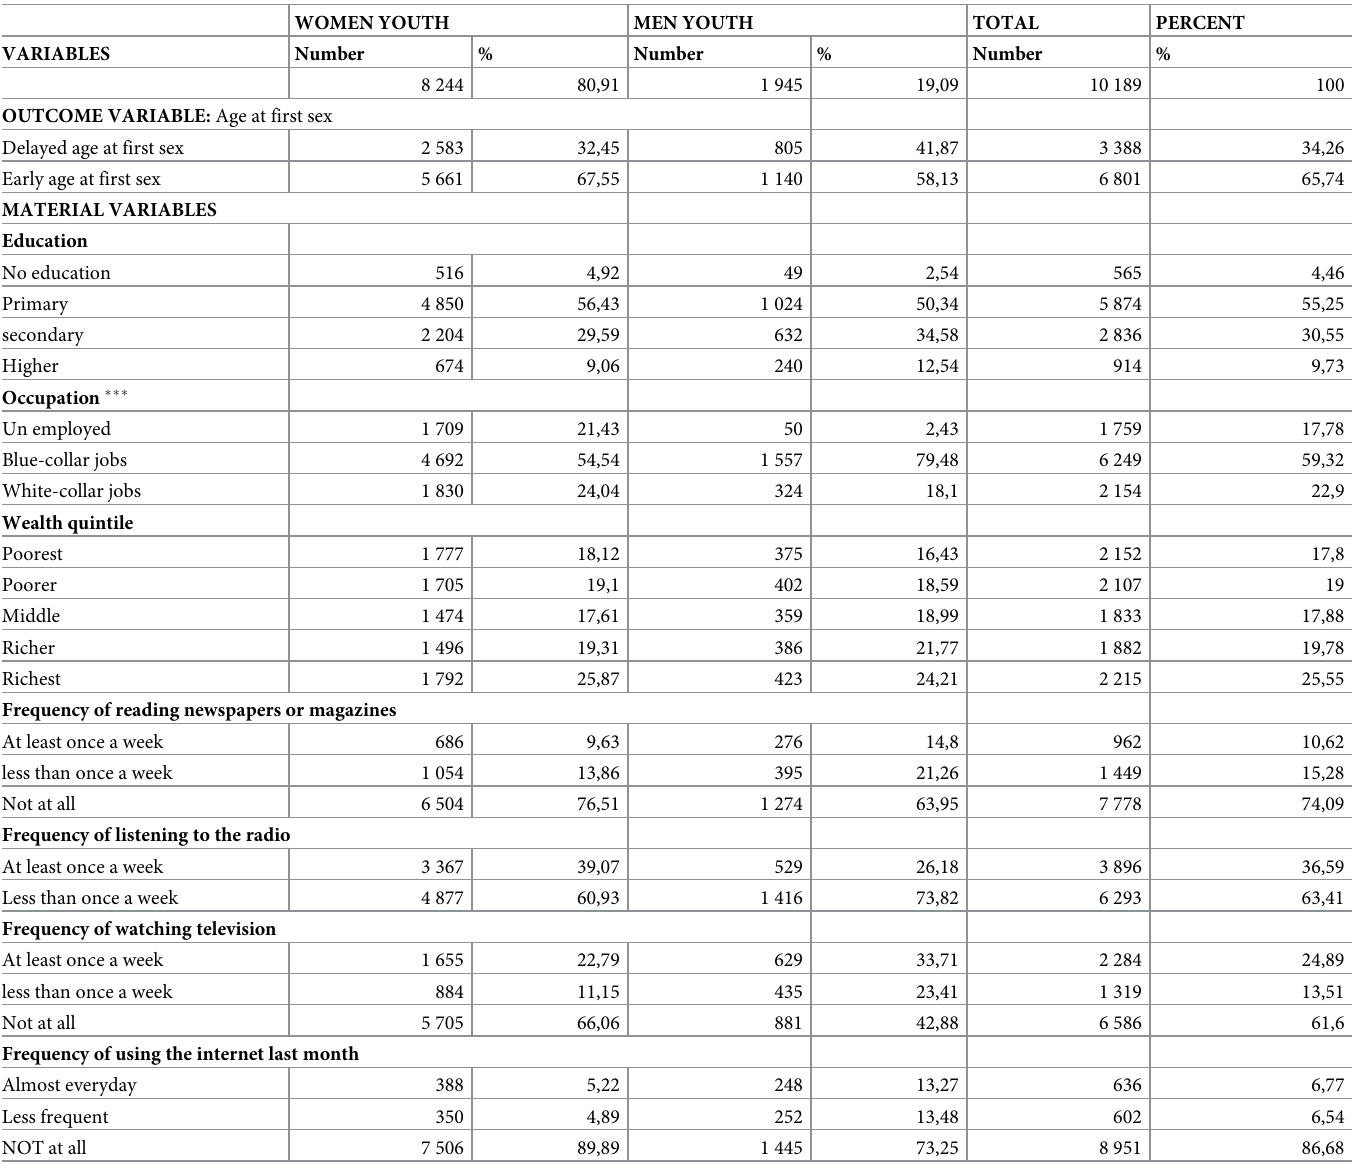
Table 1. Weighted descriptive characteristics of the study population and age at first